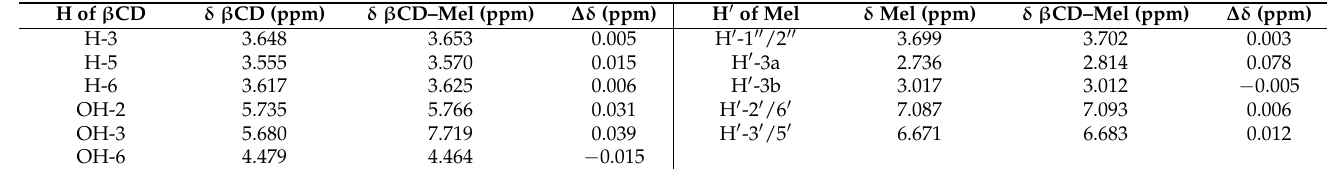
Table 1. Chemical shifts of the β CD–Mel complex and free